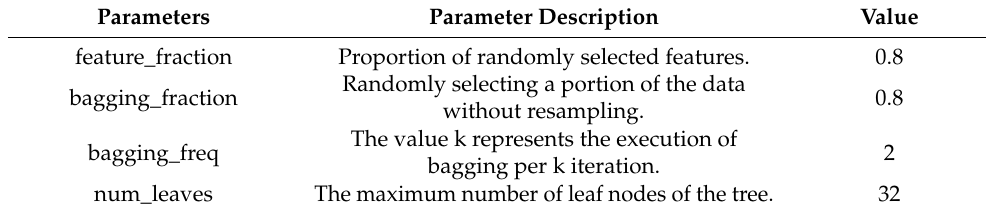
Table 3. LightGBM partial parameter